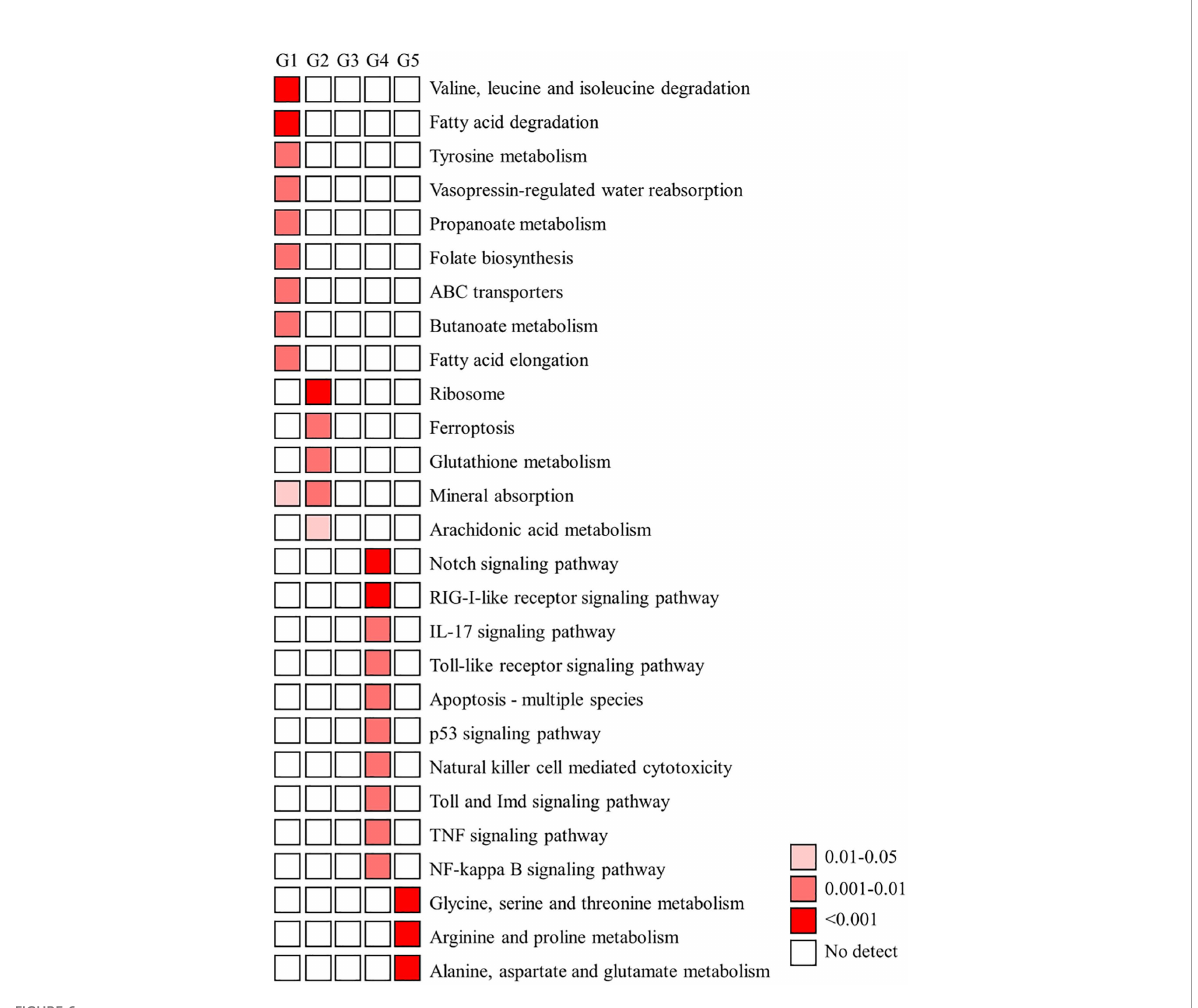
FIGURE 6 KEGG enrichment analysis of DEGs. A) The functionally enriched KEGG (Kyoto Encyclopedia of Genes and Genomes) pathways found in the analysis of differentially expressed genes (DEGs) in fi ve groups. Temporal expression pro fi les of these fi ve groups shows in Figure 4. G,